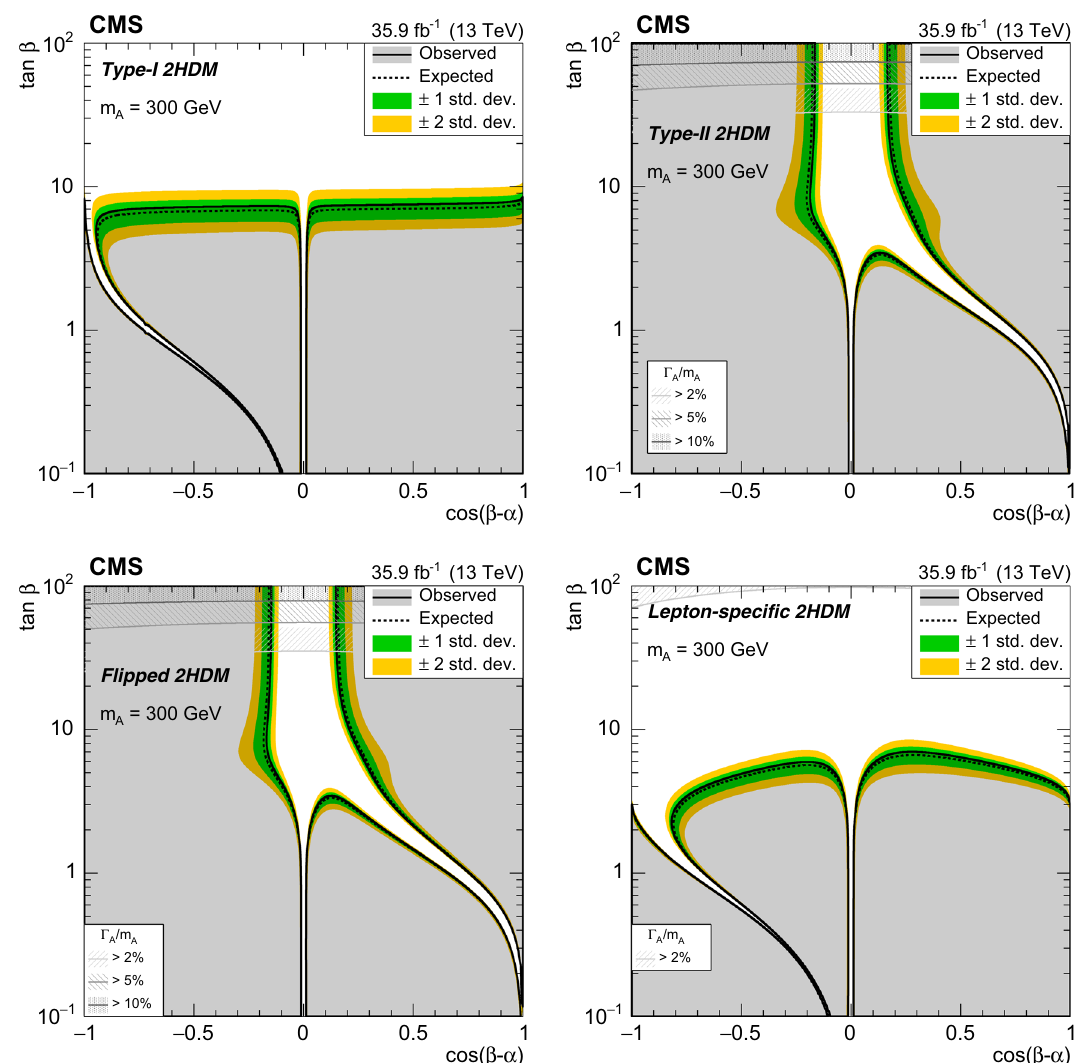
Fig. 6 Observedandexpected(with ± 1 , ± 2standarddeviationbands) exclusion limits for Type-I (upper left), Type-II (upper right), flipped (lower left), lepton-specific (lower right) models, as a function of cos (β − α) and tan β . Contours are derived from the projection on the 2HDM parameter space for the m A = 300GeV signal hypothesis.